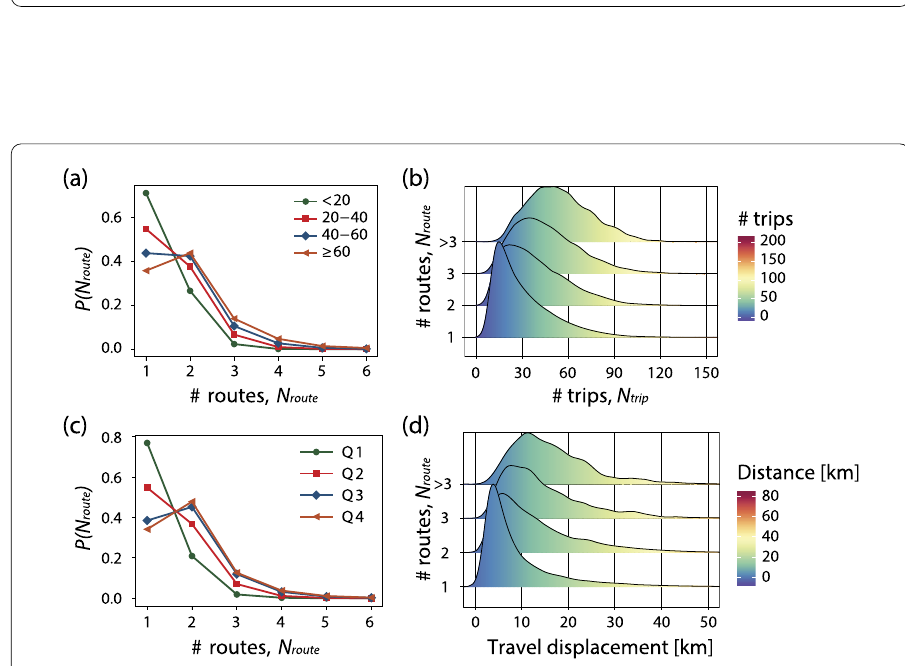
Figure 6 Connection between number of routes and the number of trips and travel displacement. ( a ) Fraction of N route for users grouped by number of trips. ( b ) Distribution of N trip of travelers with different N route , e.g., one, two, three, and more than three routes. ( c ) Fraction of N route for users grouped by range of travel distance. ( d ) Distribution of user travel displacement for travelers with different N